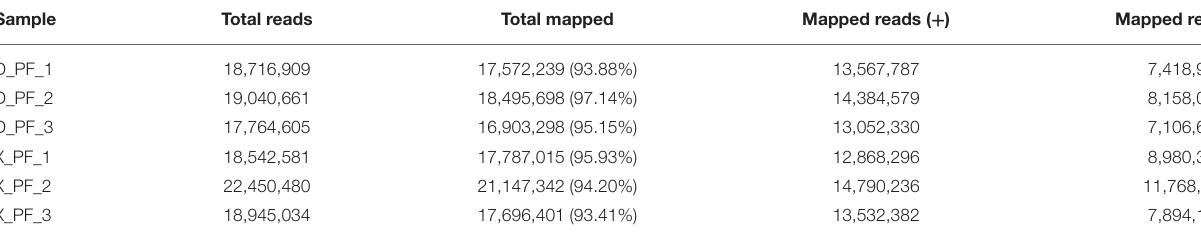
TABLE 2 | Reference genome comparison results for each sample. Sample